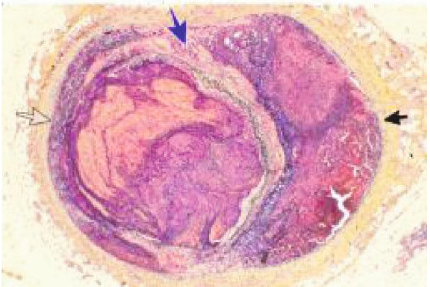
Figure 25: Segmental arterial mediolysis. Cross section of an artery with a double aneurysm. The black arrow points to a dissecting aneurysm, the clear arrow to a gap aneurysm, and the blue arrow to arterial wall segment. Movat stain × 25 (adapted with permission from Cardiovascular Pathology 18(6) copyright 2009, Elsevier Inc.).